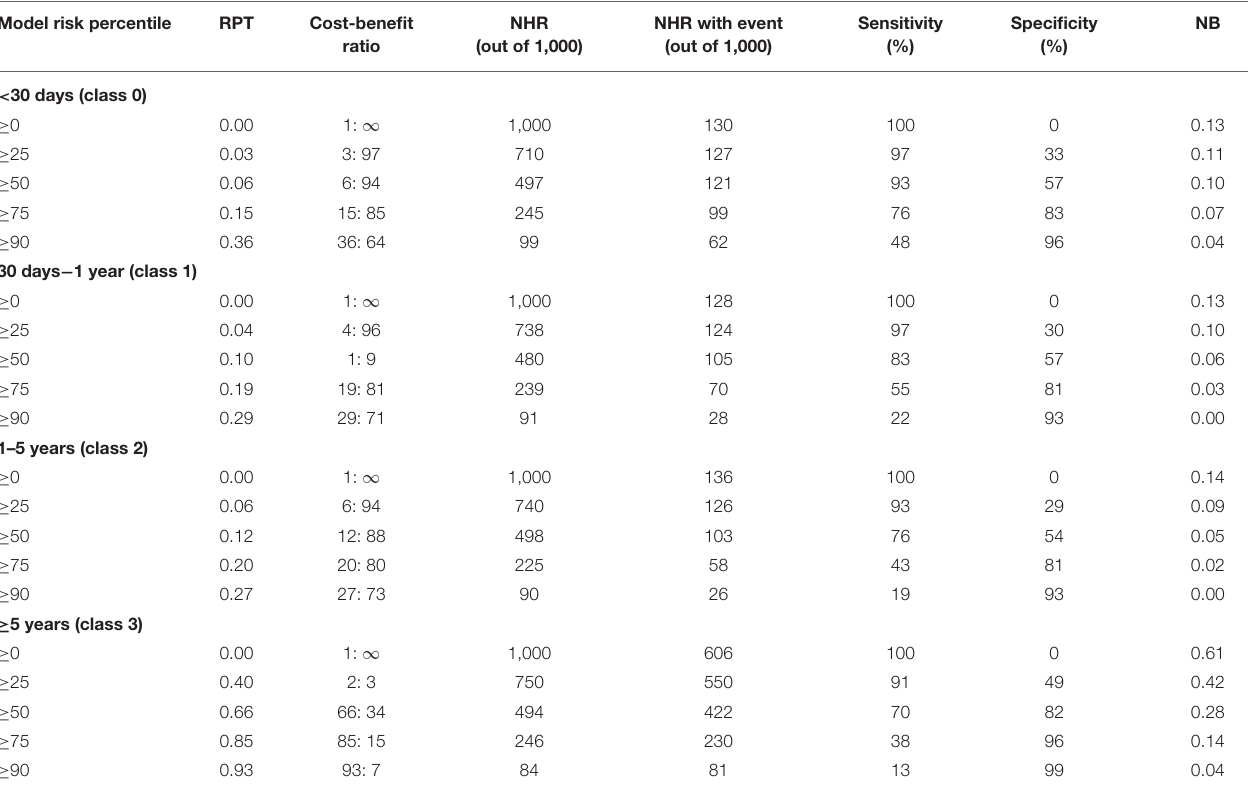
TABLE 5 | Critical prediction accuracy under different XGBoost sub-model risk thresholds. Model risk percentile